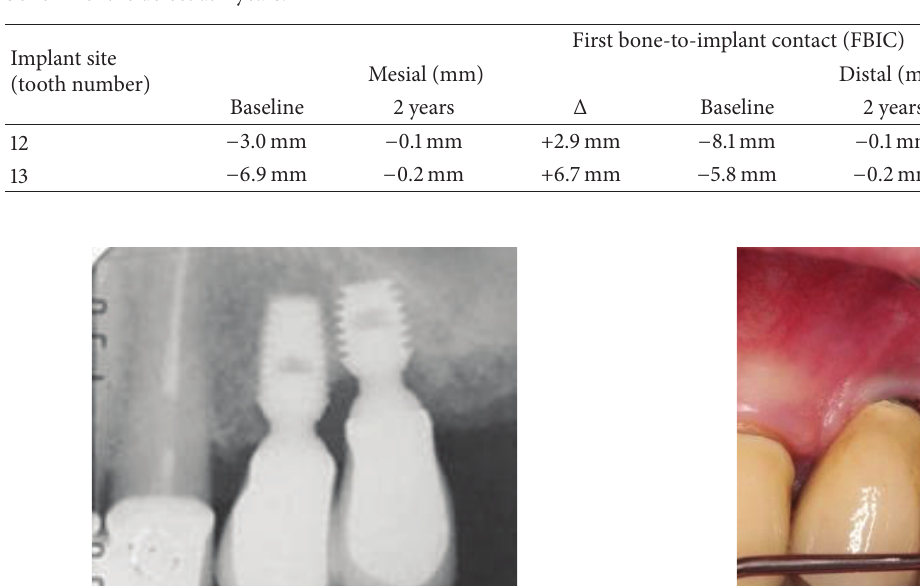
Table 2: Radiographic observations observed at baseline after 2 years and expressed as variations after 2 years. Baseline values were obtained immediatelybeforesurgery. Δ =changesofvaluescomparedwithbaselineafter2-yearfollow-upperiod.r-BF=thepercentageofradiographic bone fill of the defect at 2 years.